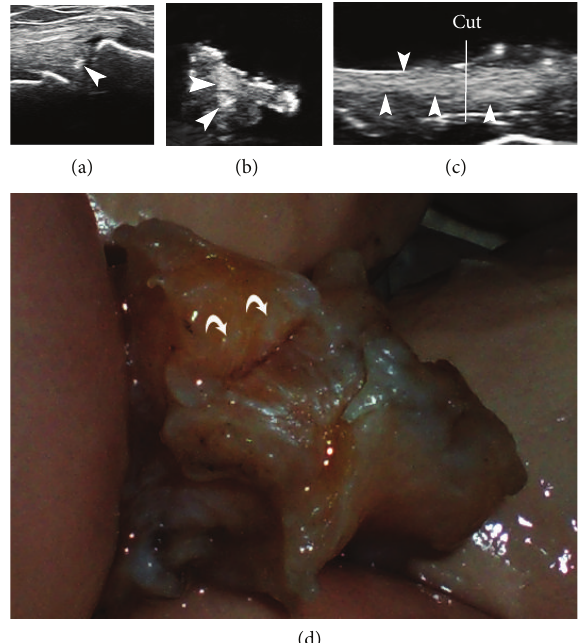
Figure 5: In vivo analysis (a), ex vivo analysis (b, c), and macroscopic analysis (d) of a medial meniscus. Note the presence of small round hyperechogenic deposits in a and b (arrowheads). The longitudinal scan of the meniscus in the ex vivo analysis highlighted the presence of hyperechogenic parallel lines (arrowheads) in the upper half of the meniscus, suggesting fibrous tissue, which in a transverse scan could resemble CPP deposits. The US guided cut (white line in panel (c) of the meniscus confirmed the presence of white lines and the absence of CPP deposits (macro- and